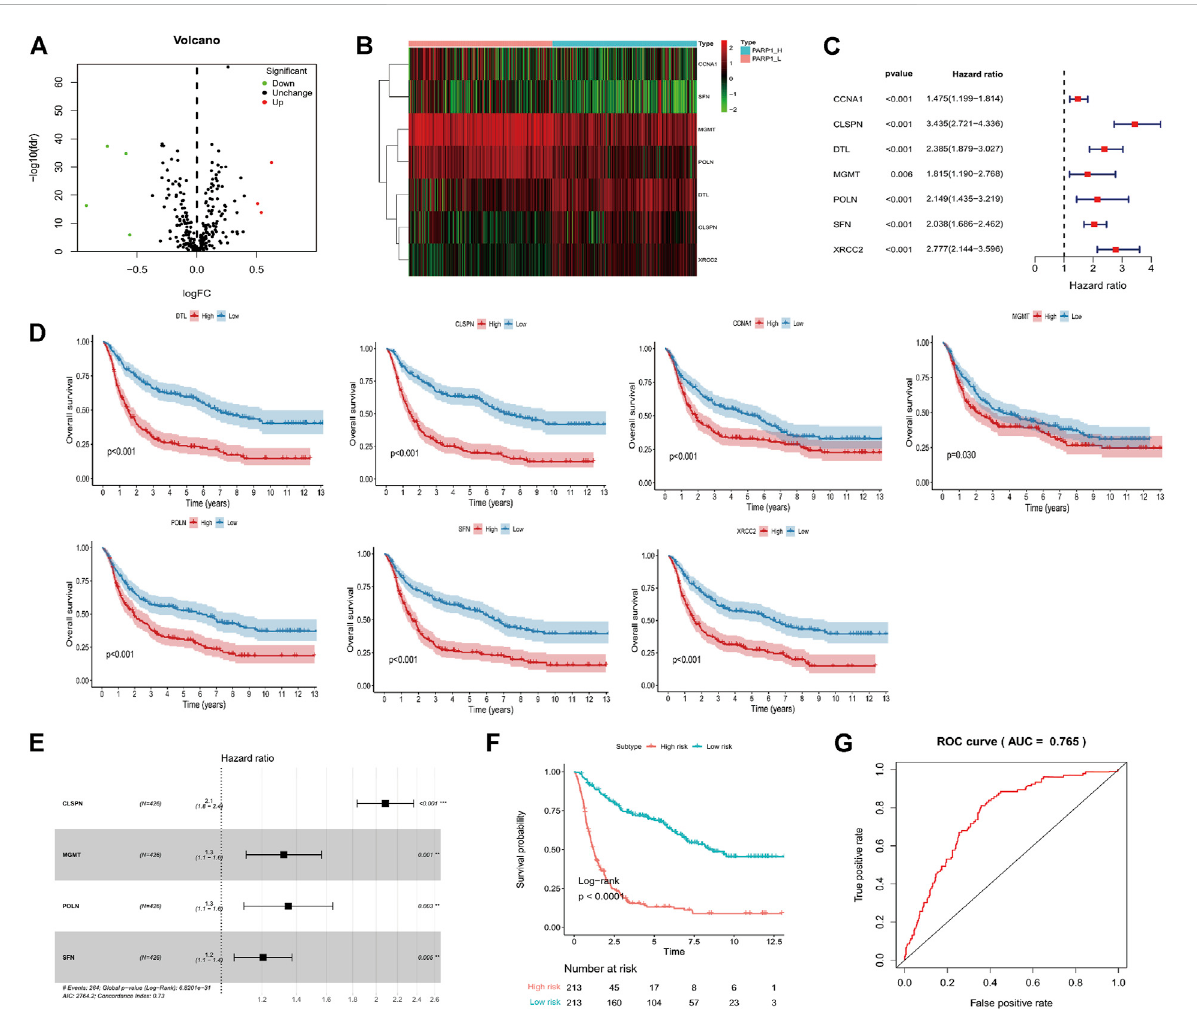
FIGURE 3 Identi fi cation of PARP1-related differentially expressed genes of DNA-repair proteins, and construction of the PARP1-related DNA-repair prognostic signature (DPS). (A) Volcano plot of 7 DNA-repair proteins differentially expressed between PARP1_L ( n = 213) and PARP1_L ( n = 213). (B) HeatmapofgenesofDNA-repairproteinsdifferentiallyexpressedbetweenPARP1_H( n =213)andPARP1_L( n =213) (C,D) .Therelationshipbetween DEG expression level and prognosis of glioma patients. The OS of glioma patients was compared between High ( n = 213) and Low ( n = 213) groups of each DEG using the Log-Rank test. (E) LASSO Cox analysis identi fi ed four genes most correlated with overall survival. (F) Kaplan-Meier curves of overall survival based on the DPS [n (high risk) = 213, n (low risk) = 213]. (G) ROC curve analysis of the